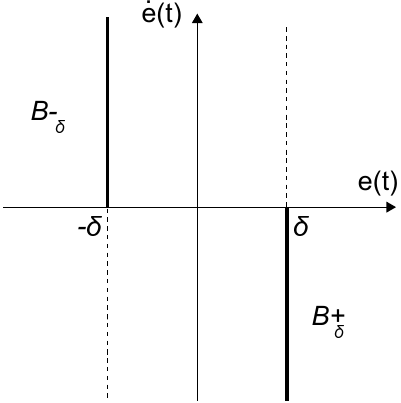
Figure 10. Fixed reset band surface.